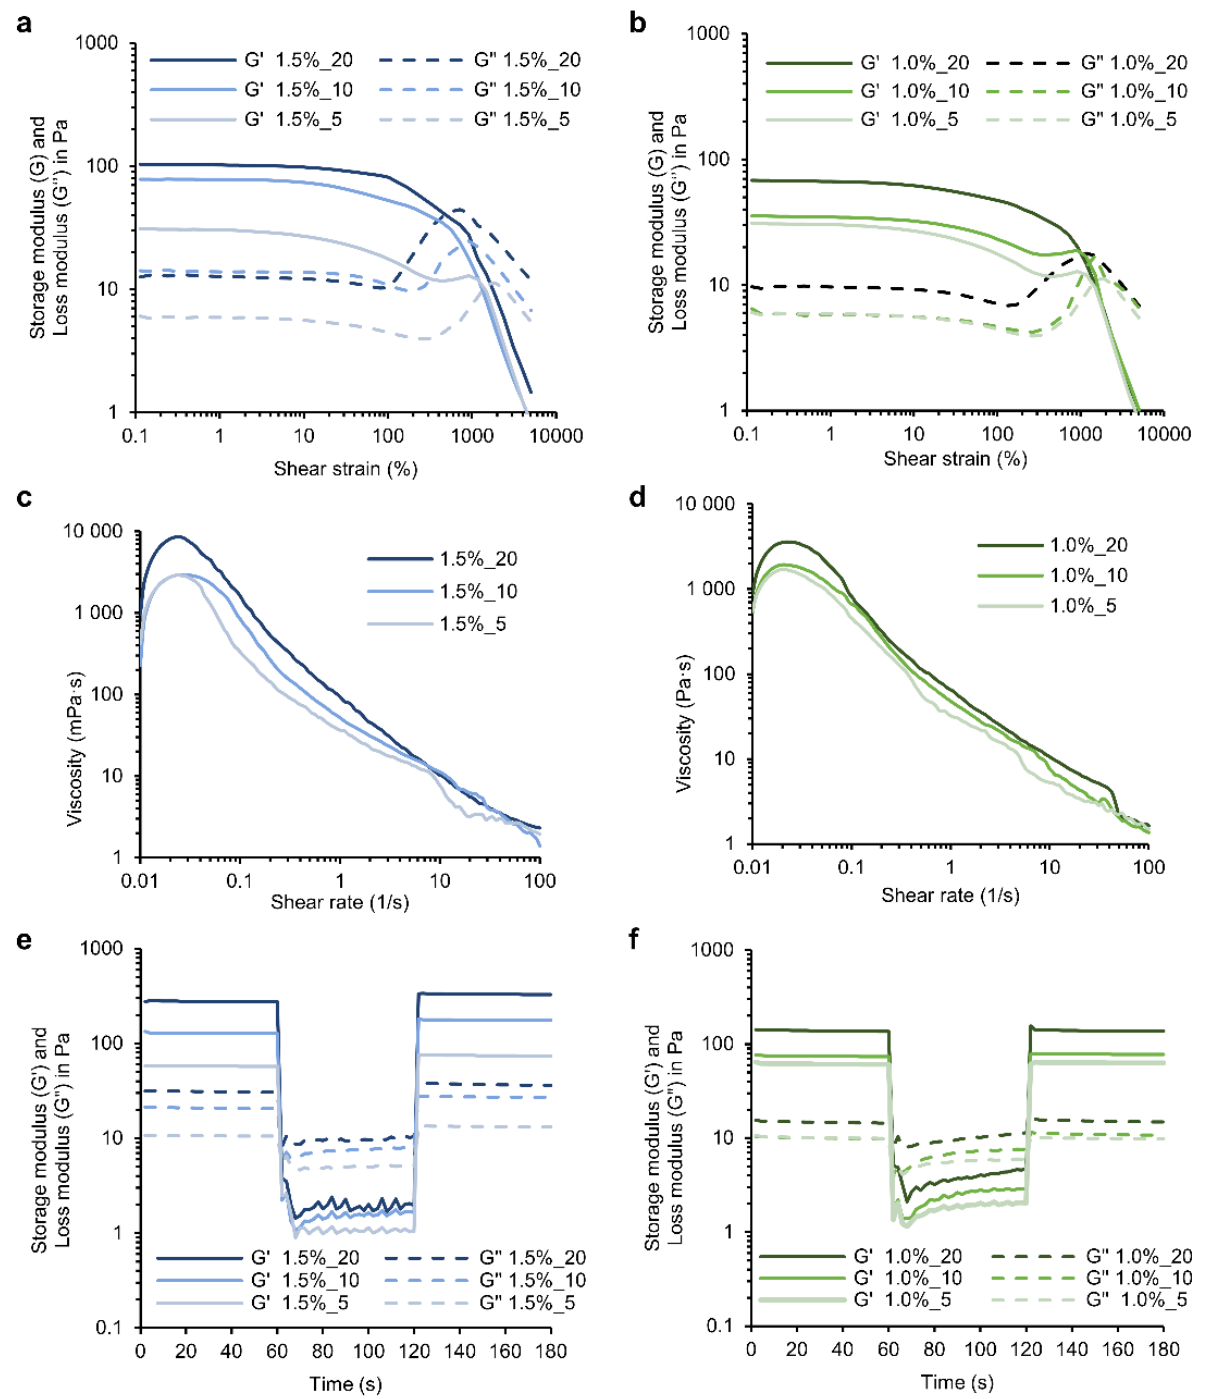
Figure 2. Rheological properties of the HA-SH/SF hydrogels. Strain-dependent oscillatory measure- ments were performed at 1 s − 1 and increased shear strains of hydrogels prepared with ( a ) 1.5% or ( b ) 1.0% of polymers with varying PLN contents. Viscosity vs. shear rate of hydrogels prepared with ( c ) 1.5% or ( d ) 1.0% of polymers, varying PLN content. 3iTT of hydrogels prepared with ( e ) 1.5% or ( f ) 1.0% of polymers with varying PLN contents, with intervals combining 5 and 2000% strains at 1 s − 1 . All the tests were performed at 25 ◦ C using a solvent trap. For simplification of the data interpretation, one representative sample per experimental group (n = 3) is